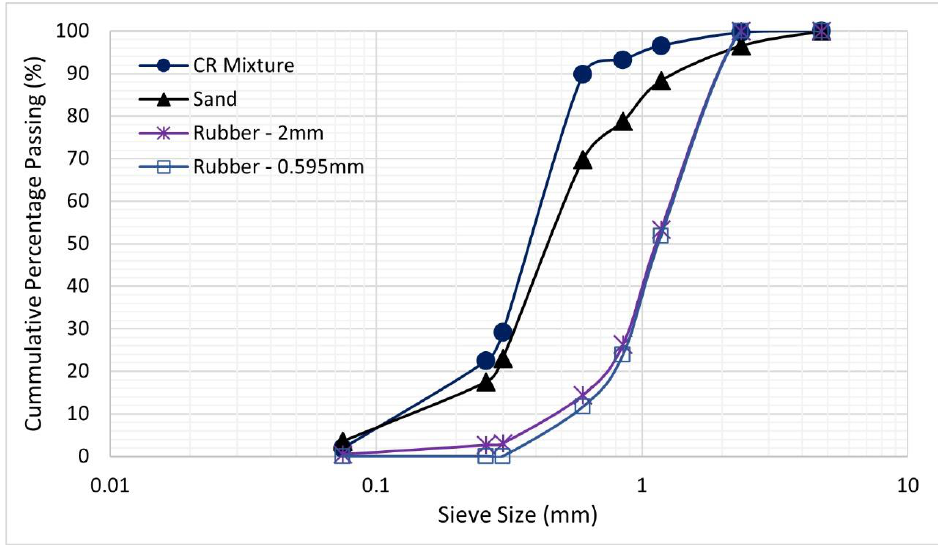
Figure 2. Particle Size Distribution Curve for Sand, Rubber, and Rubber Mix.